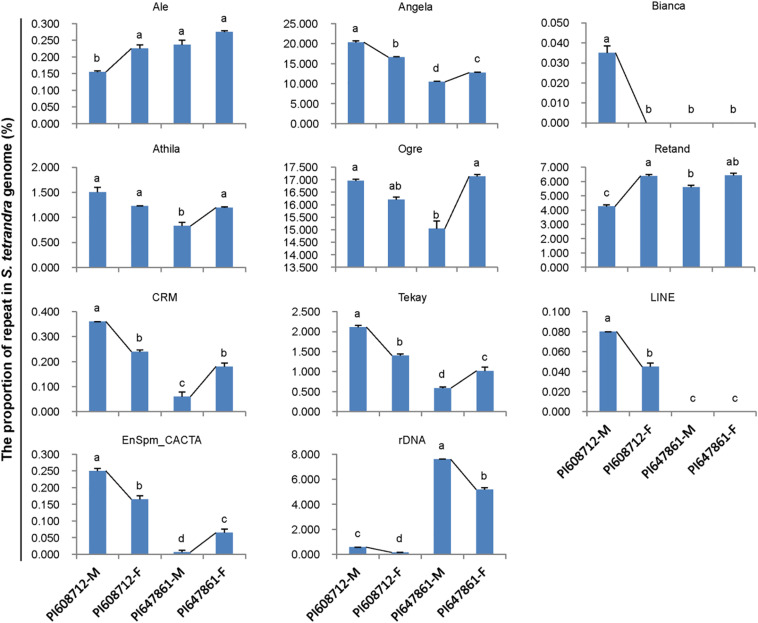
The differentially abundant repeats between male and female genome in two accessions of S. tetrandra. PI608712 with homomorphic sex chromosomes, PI647861 with heteromorphic sex chromosomes; PI608712-F, female genome of PI608712; PI608712-M, male genome of PI608712; PI647861-F, female genome of PI647861; PI647861-M, male genome of PI647861; the black line linking two bars indicates the variation trend; “a, b, c, d,” means significance level by multiple comparison, p < 0.05.